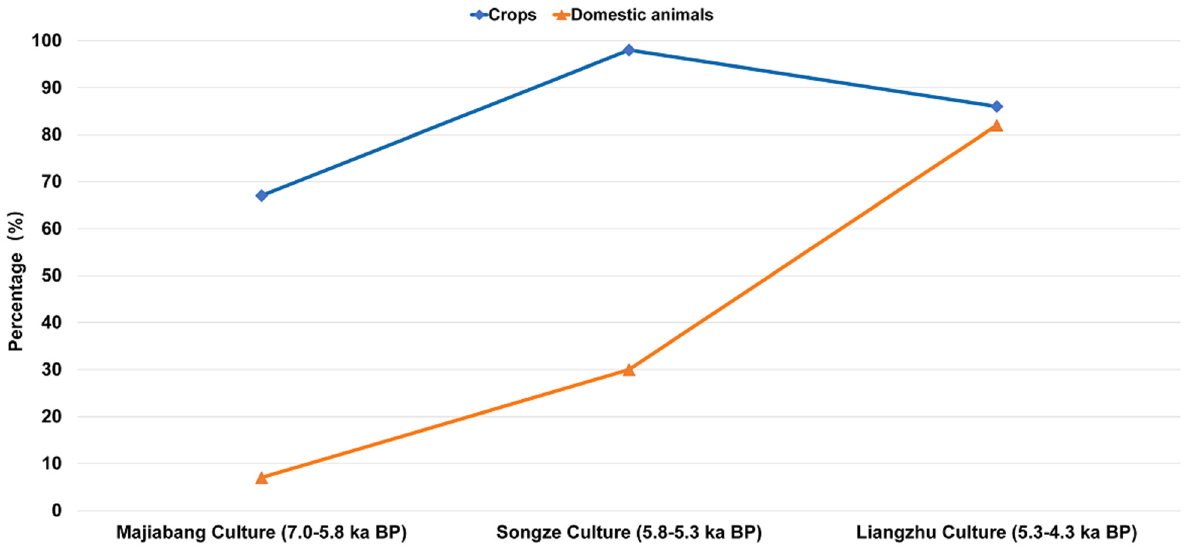
Figure 6. Temporal changes in the relative proportions of crops and domestic animals consumed by the Neolithic people in the area around Taihu Lake.